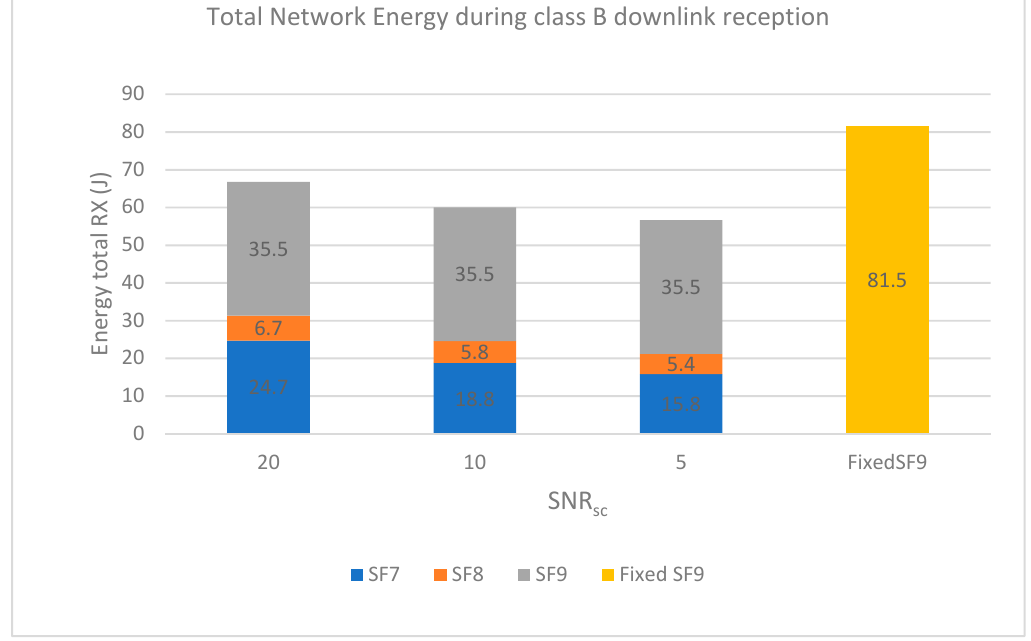
Figure 15. Total energy consumed by receptions by EDs in the network for 24 h with downlink periodicity of 1950 s.